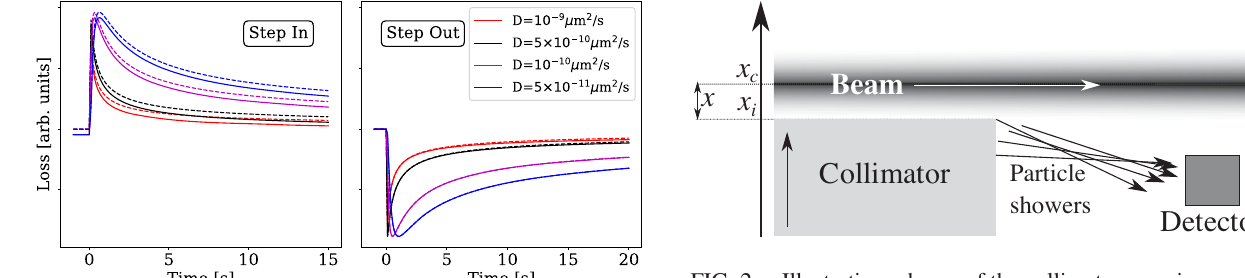
FIG. 2. Illustrative scheme of the collimator scraping apparatus for probing beam tails: one collimator jaw is moved into the beam, while the induced beam losses are measured locally by means of beam loss